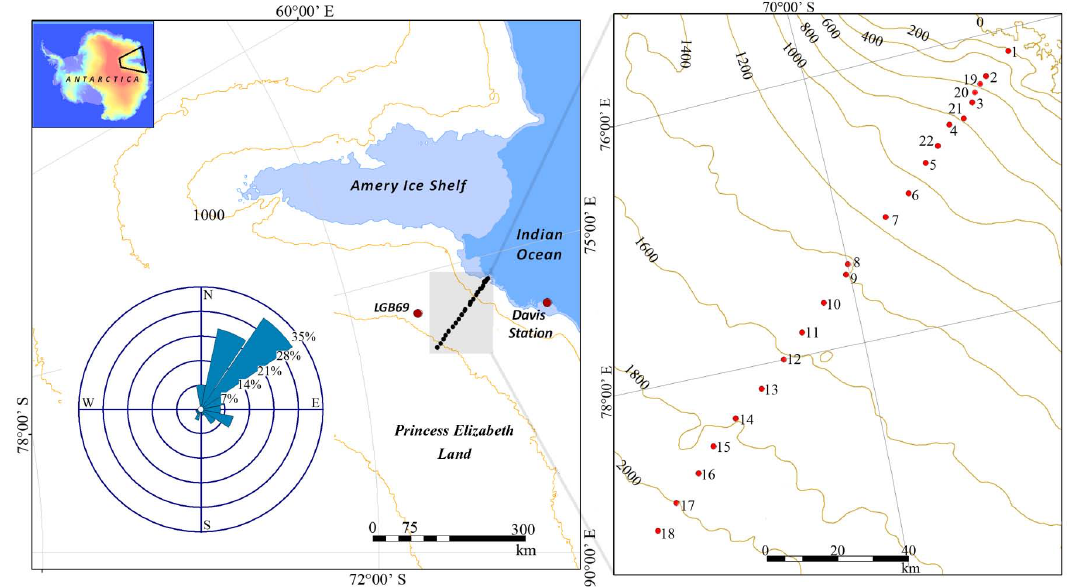
Fig. 1. Map showing the sampling locations in Princess Elizabeth Land transect. Inset on the left corner shows the wind rose chart for 2008, showing prevalent wind direction (NNE–ENE) on the